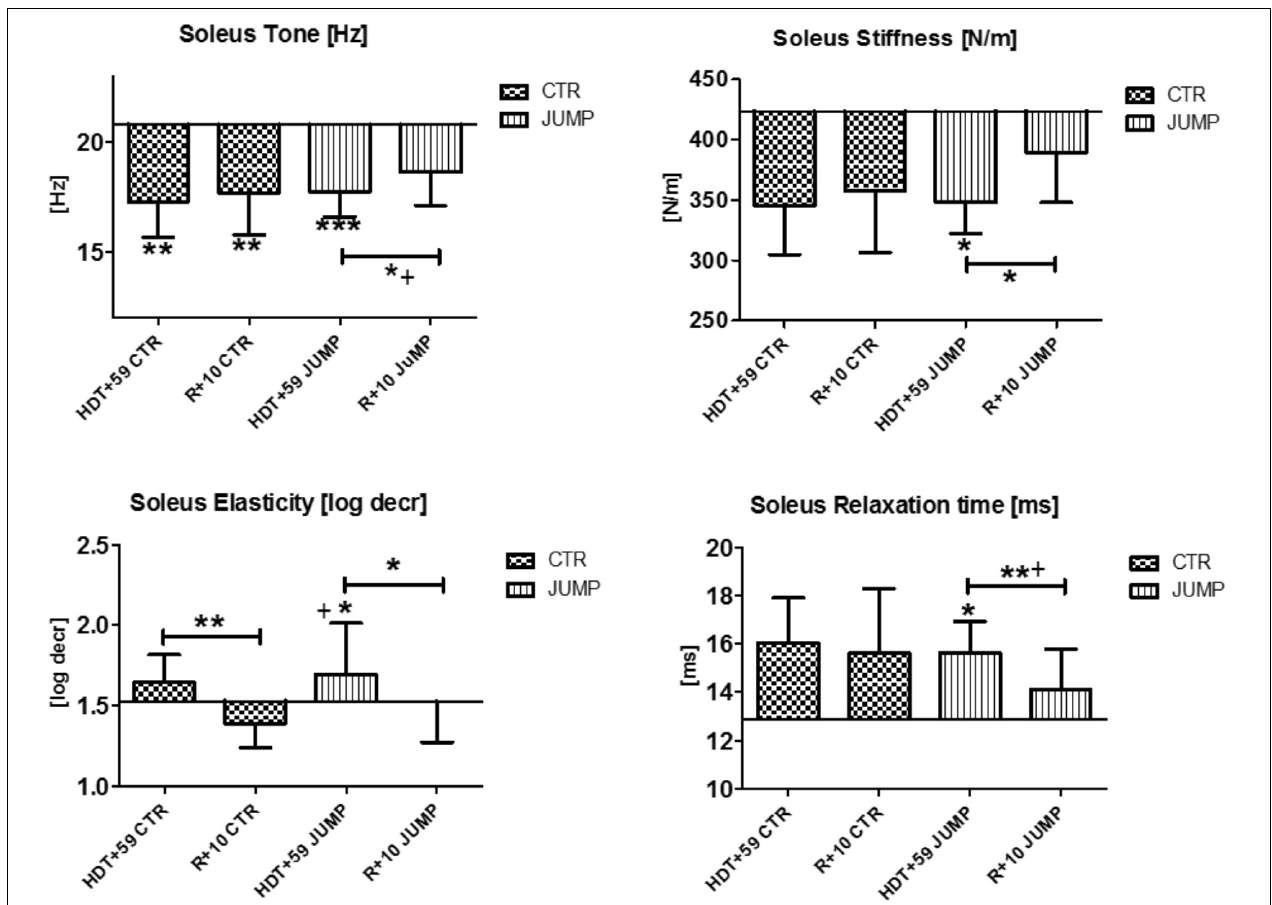
FIGURE 9 | Soleus (MP17/18). Oscillation signal patterns in RSL bed rest study. ABD = average baseline data (Tone HDT+1 = 20.77; Stiffness HDT+1 = 423.33; Elasticity HDT+1 = 1.53; Relaxation HDT+1 = 12.89). ∗ p < 0.05, ∗∗ p < 0.01, ∗∗∗ p < 0.001 ± SD, +Spearman ρ .